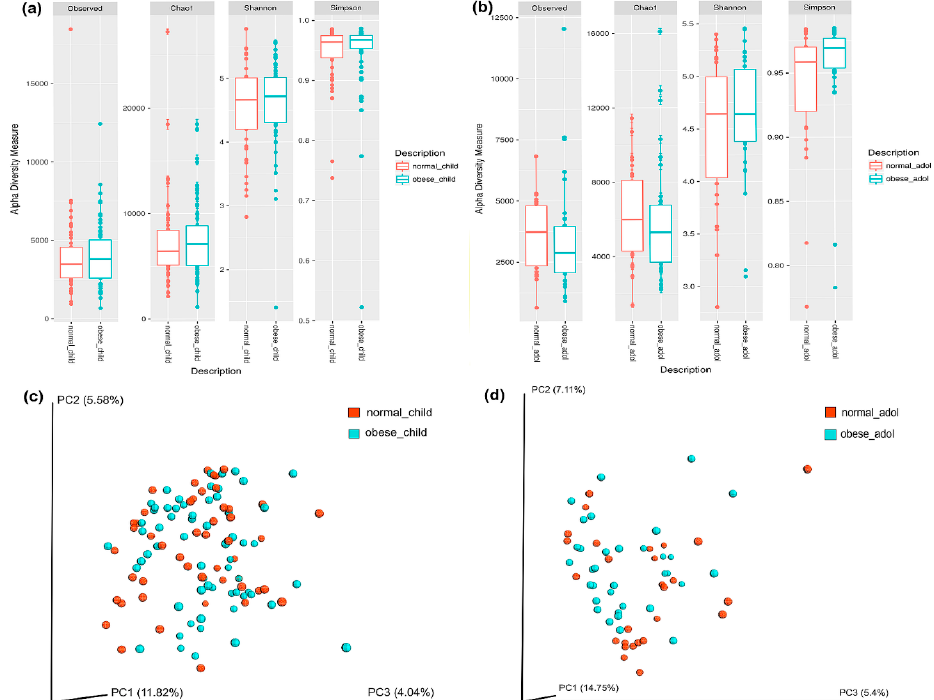
Figure 1. Characterization of alpha-diversity of the gut microbiota in children ( a ), and adolescents ( b ). The y-axes show the Observed numbers of species, Chao1 richness index, and the Shannon and Simpson diversity indexes. The x-axes show the phenotypic categories. Additional data are in Table S2. The gut microbiota beta diversity of normal weight and obese individuals in children ( c ) and adolescents ( d ), was calculated by dissimilarity metrics using operational taxonomic unit (OTU) tables and Unweighted UniFrac analyses. The analysis shows the dissimilarity between normal weight and obese individuals. Three-dimensional scatter plots were generated using principal coordinates analysis (PCoA). Tags beside the graphics are normal weight children, obese children, normal weight adolescents, and obese adolescents. Normal weight individuals are shown in orange, and obese individuals are shown in blue color. Data were analyzed as described in the Materials and Methods